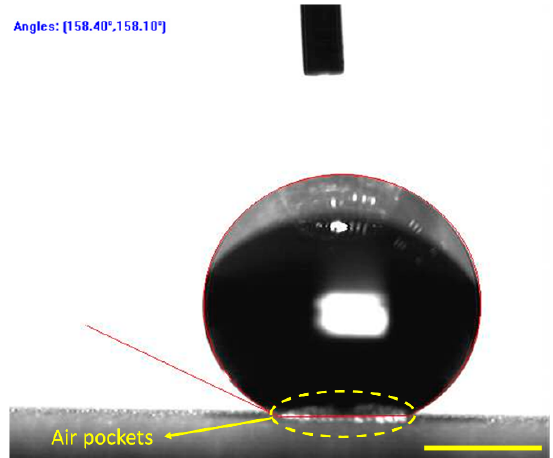
Figure 6. Optical picture of a 6 μ L water droplet on the fabricated substrate. The scale bar is 1 mm.